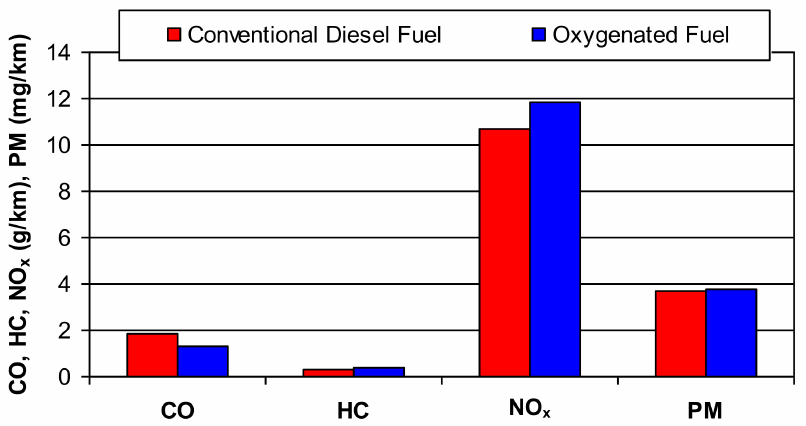
Figure 8. Average road emissions in the SORT 2 cycle from the Solaris Urbino 18 Hybrid bus fuelled by conventional diesel fuel and oxygenated fuel.